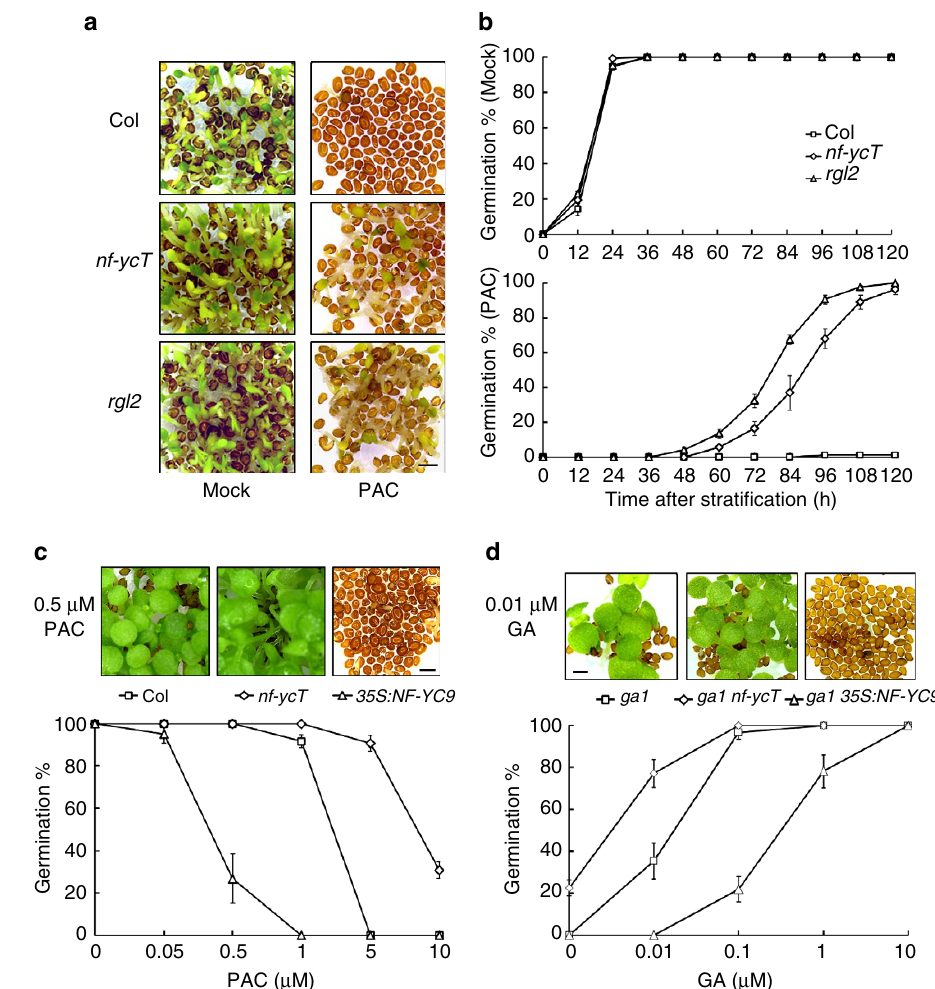
Figure 1 | NF-YCs inhibit GA response in seed germination. ( a ) Loss of function of three NF-YC homologues or RGL2 decreases the sensitivity of seeds germination to PAC. Germination phenotypes of nf-yc3-2 nf-yc4-1 nf-yc9-1 ( nf-ycT ), rgl2 and the wild-type (Col) seeds were observed at 96 HAS (hour after stratification) on 1/2 MS medium containing 5 m M PAC or mock, respectively. ( b ) Statistic analysis of germination rate in nf-ycT , rgl2 and the